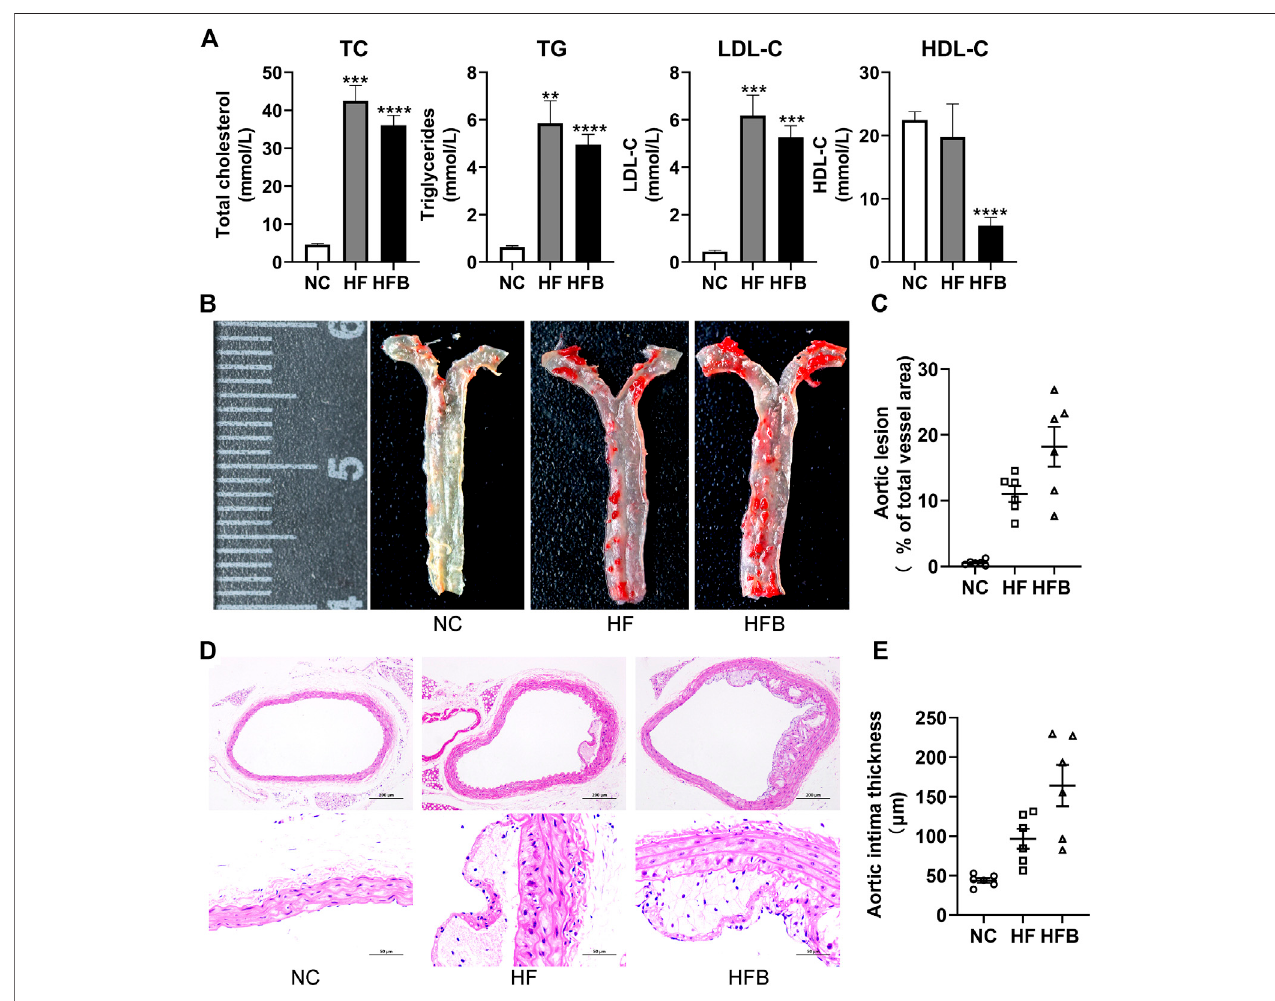
FIGURE 2 | Evaluation of atherosclerosis formation in ApoE − / − mice fed high-fat diets. (A) Plasma lipid levels in mice, from left to right: total cholesterol (TC), triglycerides(TG),low-densitylipoproteincholesterol(LDL-C),andhigh-densitylipoproteincholesterol(HDL-C),respectively. (B) GrossstainingofoilredOinthethoracic aortaofmice(attheendofthe16thweek). (C) Statisticalmapofthoracicaorticplaqueareainmice. (D) HEstainingofmiceaorticarch(attheendofthe16thweek;×100, 100-fold; ×400, 400-fold). (E) Statistical maps of intima-media thickness (IT) in mice. n = 6, mean ± SEM. *, p < 0.05; **, p < 0.01; ***, p < 0.005; ****, p < 0.001; vs.